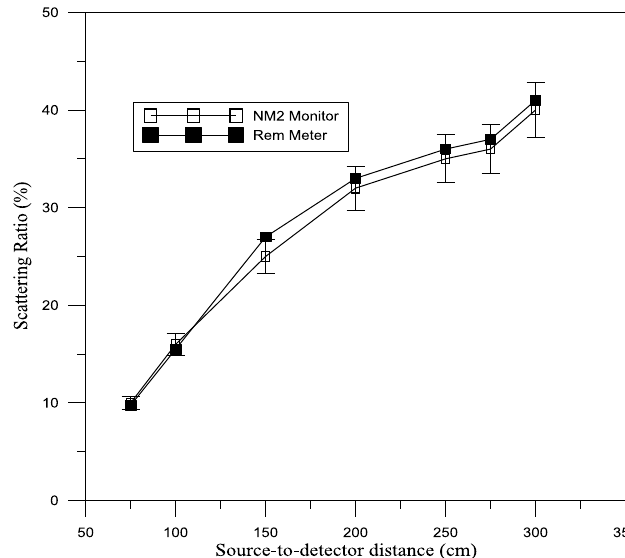
Fig. 6. Neutron scattering ratio as measured with different probe shape with different distances.